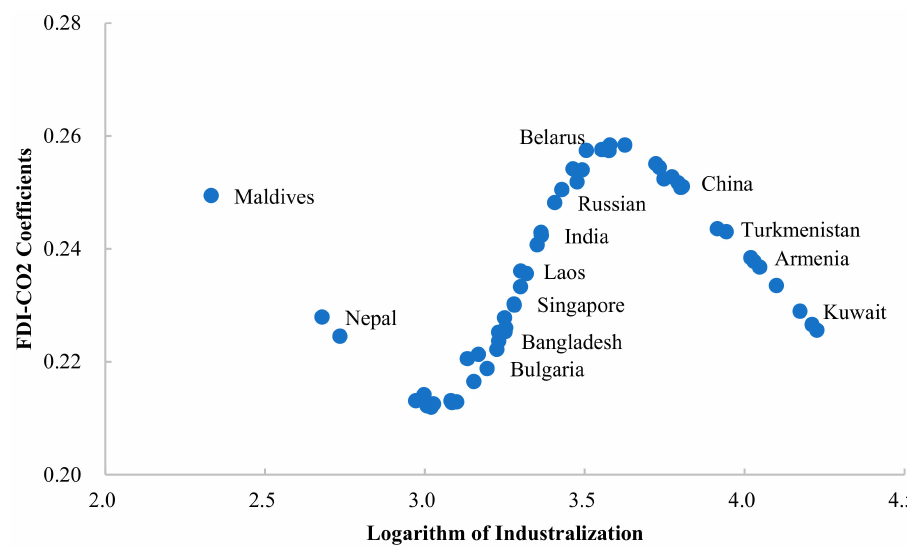
Figure 4. FDI-CO 2 coefficients of Belt and Road countries (Industrialization threshold).